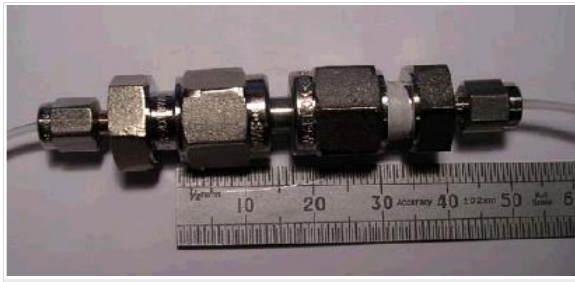
Figure 1: Stainless steel single column flow reactor for discovery scale